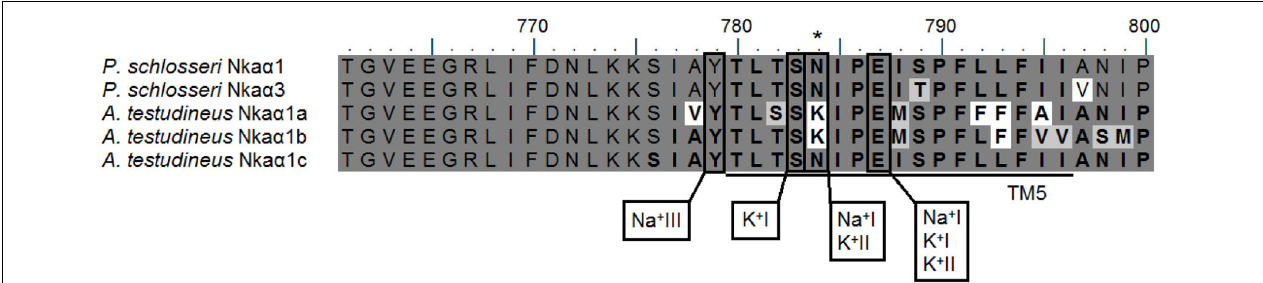
FIGURE 6 | Analysis of Na + /K + binding site of Na + /K + -ATPase (Nka) α 1 and Nka α 3. A multiple amino acid sequence alignment of a region of Nka α 1 and Nka α 3 from gills of Periophthalmodon schlosseri , with Nka α 1a (GenBank: JN180940), Nka α 1b (GenBank: JN180941), and Nka α 1c (GenBank: JN180942) from the gills of Anabas testudineus . Identical